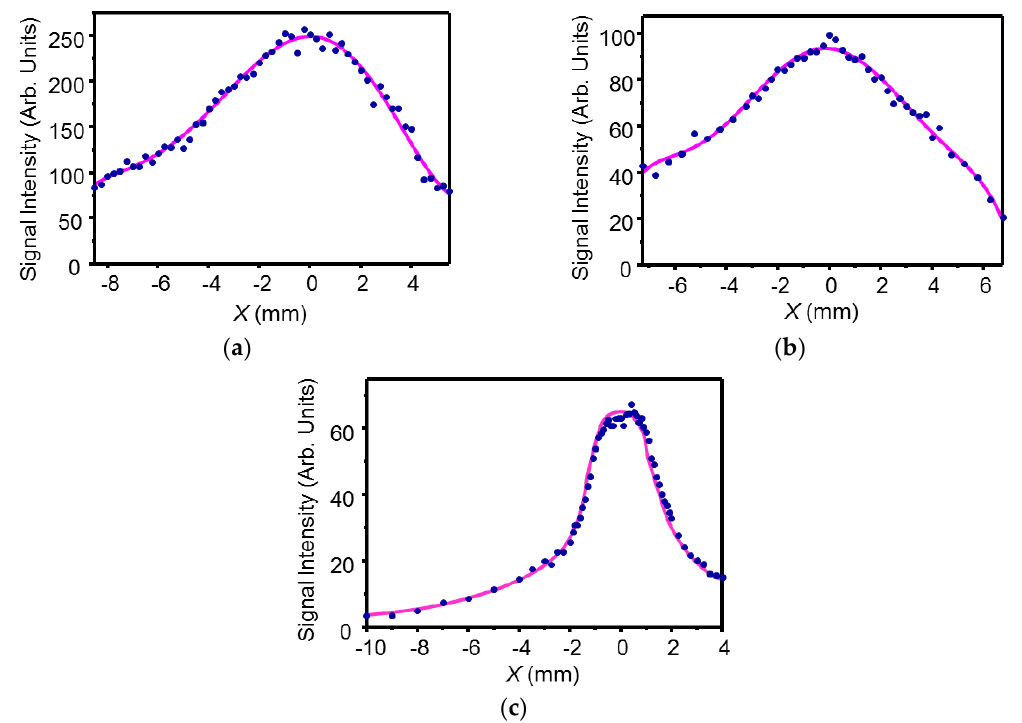
Figure 3. Observed dependence of the signal intensity, I 2FRAC (τ = 0), on the parameter, X . The dots in the figure are the observed data, and a solid curve is a guide to the eye. The parameter of X 1/2 can be obtained by calculating the half width at the half maximum of the signal peak. Laser operating wavelengths: ( a ) 267; ( b ) 241; and ( c ) 219 nm.